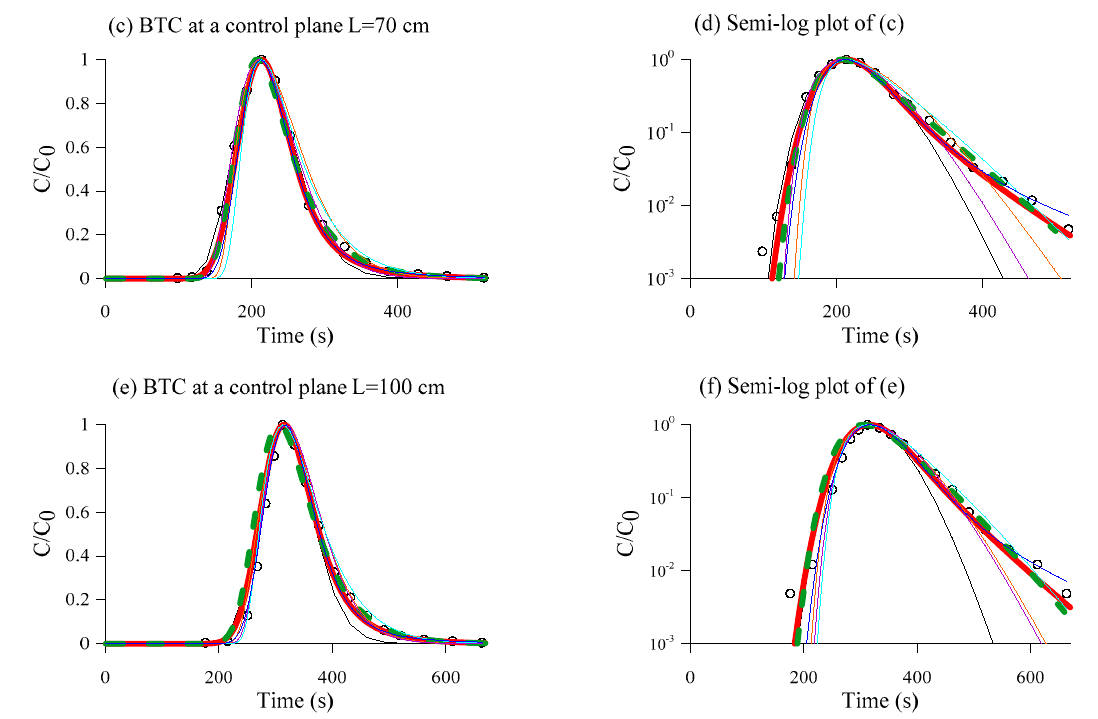
Figure 2. Laboratory tracer test: Comparison between the measured (symbols) and the modeled (lines) breakthrough curves (BTCs) using the advection–dispersion equation (ADE), the tempered time fractional advection–dispersion equation (tt-fADE) (red thick lines), the continuous time random walk (CTRW) (green dashed lines), and the multi-rate mass transfer (MRMT) model with the water flow rate Q = 1.4 mL/s.